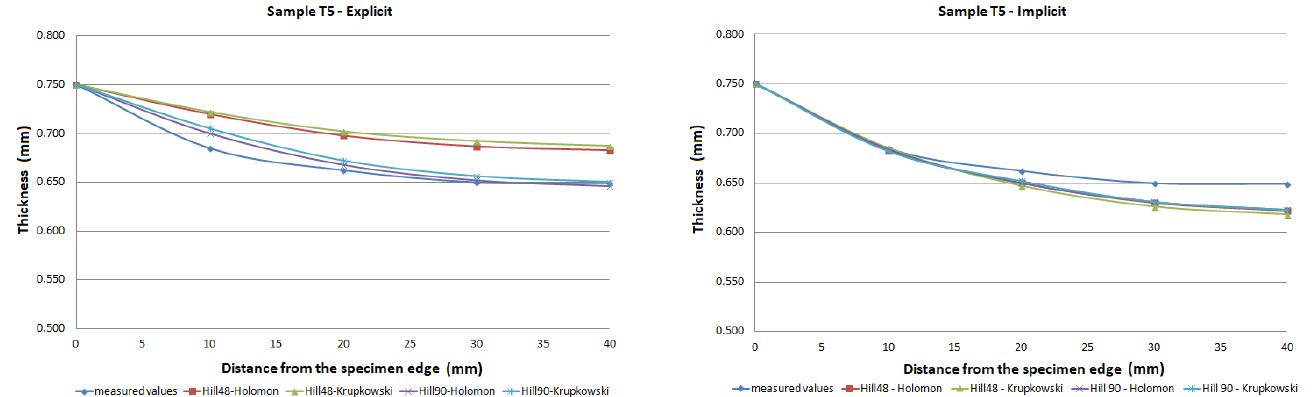
Figure 15. Comparison of predicted and measured thickness values of sample T4 using different types of yield criteria, hardening laws and integration scheme.